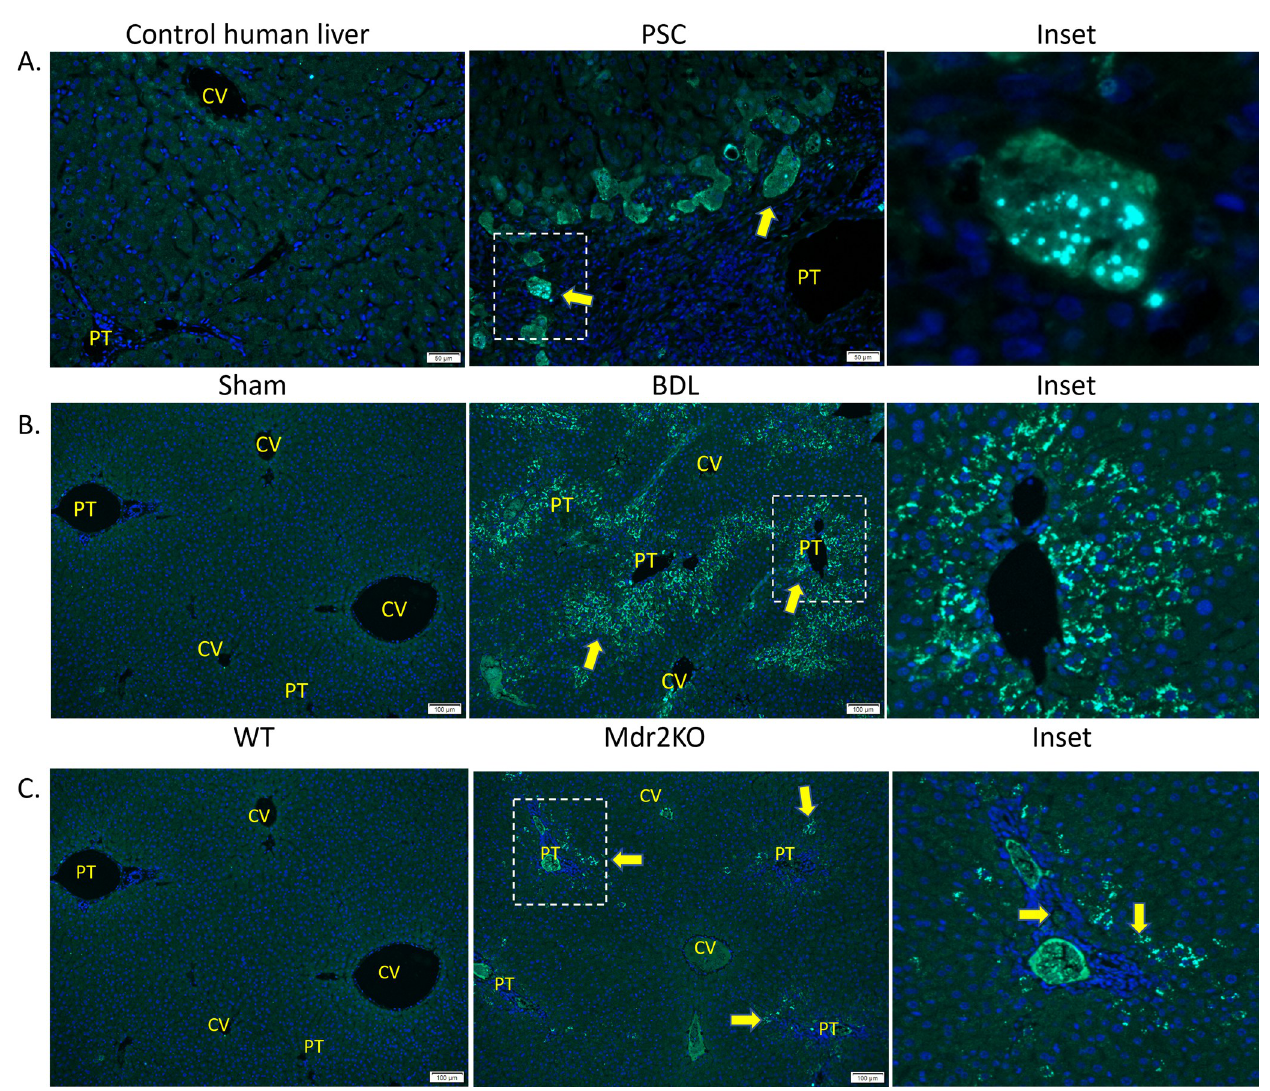
Fig 8. Colocalization of p62 and 4-HNE in liver in cholestasis A. Control and PSC liver (200X). B. Sham and BDL cholestatic liver (100X) C. WT and Mdr2 KO liver (100X). Arrows indicate periportal hepatocytes of increased staining/colocalization. n = 4/group, Blue-Dapi, Green-4-HNE, Cyan-p62. CV- central vein, PT-portal